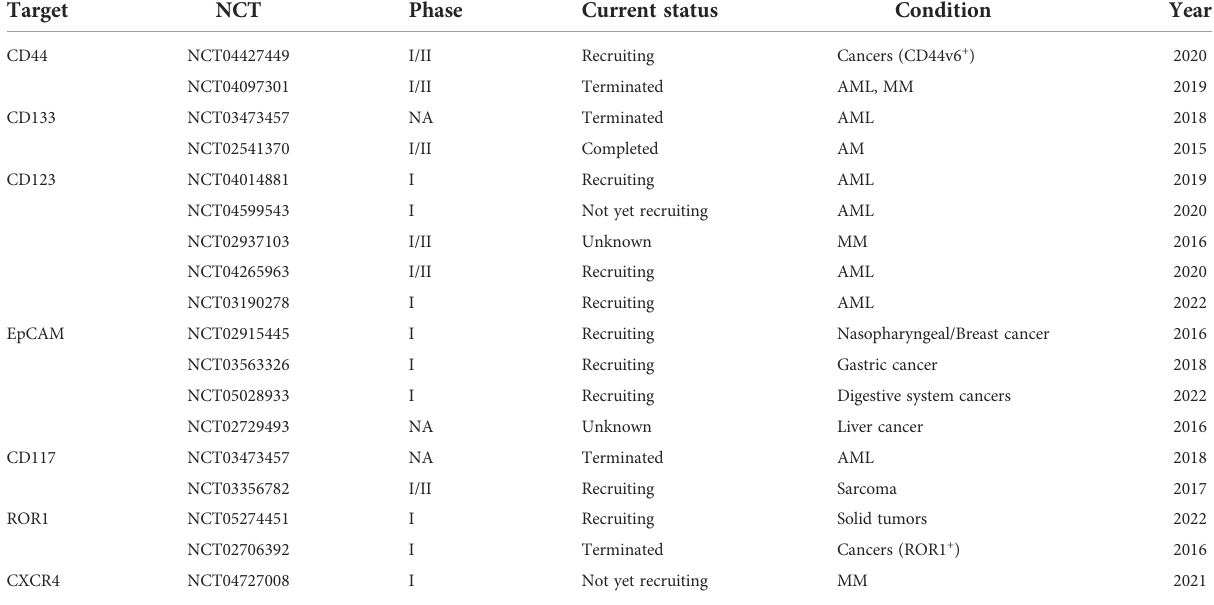
TABLE 3 The current clinical trials with CAR therapy targeting